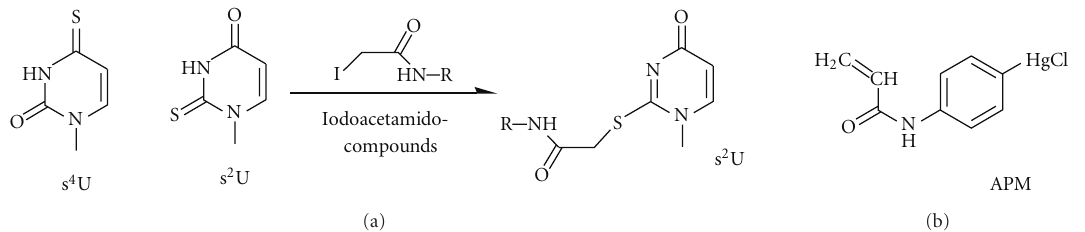
Figure 6: Examples of thiolated nucleotides found in RNA (a) and ( N -acryloylamino)phenyl-4-mercuric chloride (APM) which is used for gel-retardation detection of thiolated molecules. (b) Reaction of thiolated nucleotides with iodoacetamide and its derivatives. s 2 U is taken to illustrate the reaction